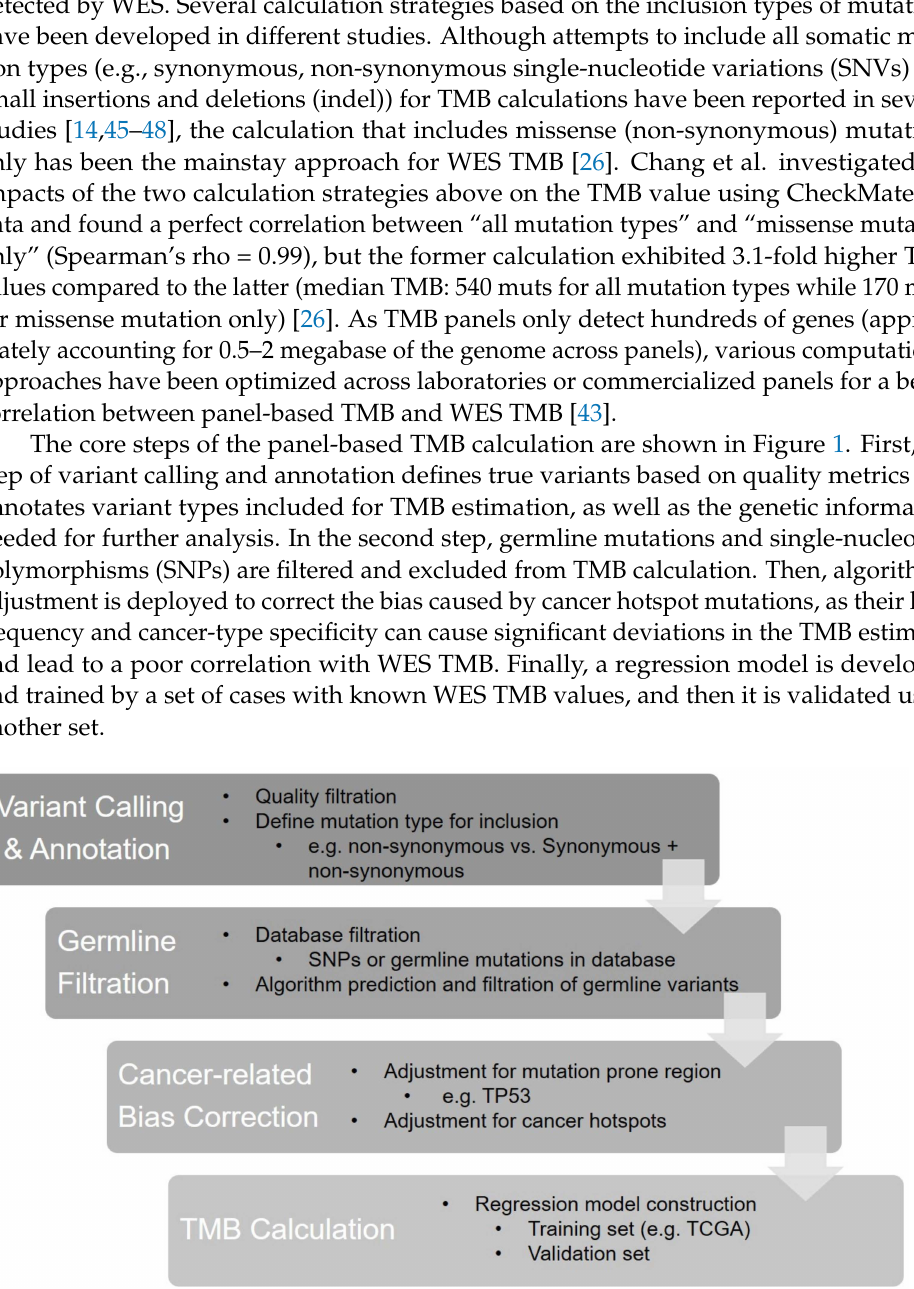
Figure 1. The bioinformatics algorithm of panel-based TMB